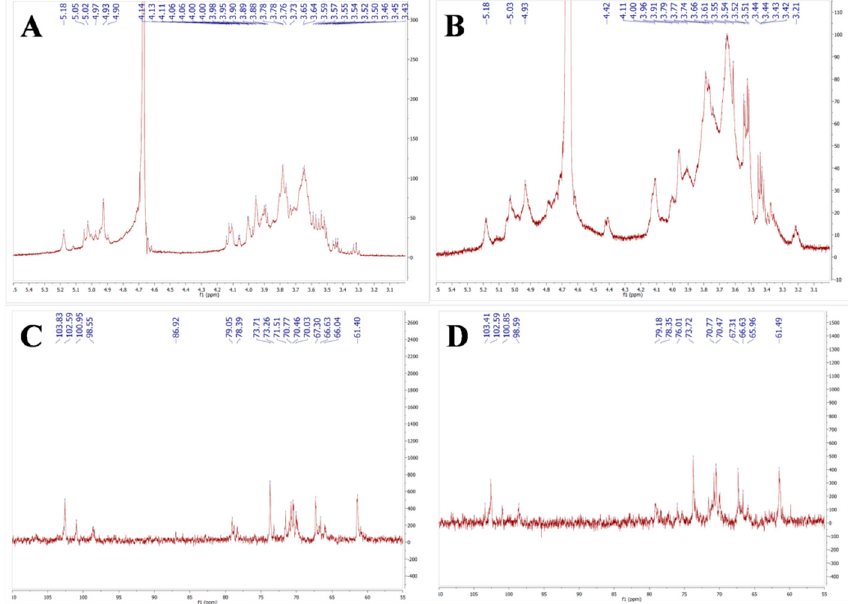
Figure 4. NMR spectra of AMEP-1 and AMEP-2: ( A ) 1 H-NMR spectrum of AMEP-1; ( B ) 1 H-NMR spectrum of AMEP-2; ( C ) 13 C-NMR spectrum of AMEP-1; and ( D ) 13 C-NMR spectrum of AMEP-2.